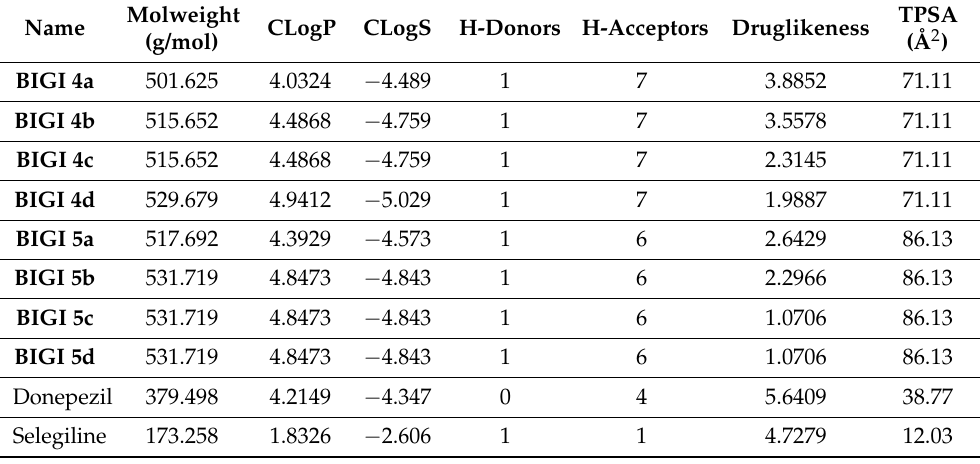
Table 3. Physicochemical properties of the synthesized compounds calculated by Data